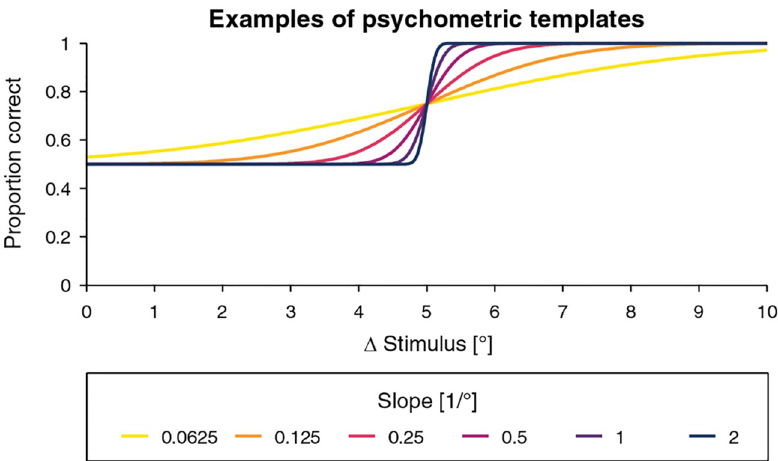
Fig 4. Examples of psychometric templates. Examples of psychometric templates c > different slopes used in the computer